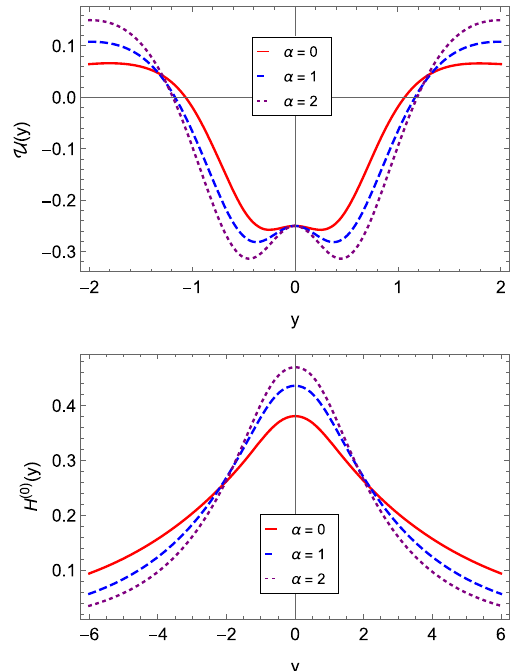
Fig. 13 Stability potential U ( y ) (top panel) and graviton zero-mode H ( 0 ) ( y ) (bottompanel)forthenumericalsolutionsobtainedinSect.3.2, with ψ 0 = − 1, U 0 = k = 1, A 0 = 0 for different values of